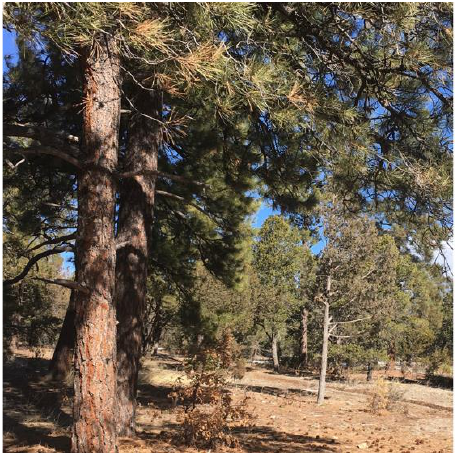
Figure 1. The Forest Bathing walks took place primarily in ponderosa pine, pinyon, and juniper habitat, as can be seen in this picture of the intervention